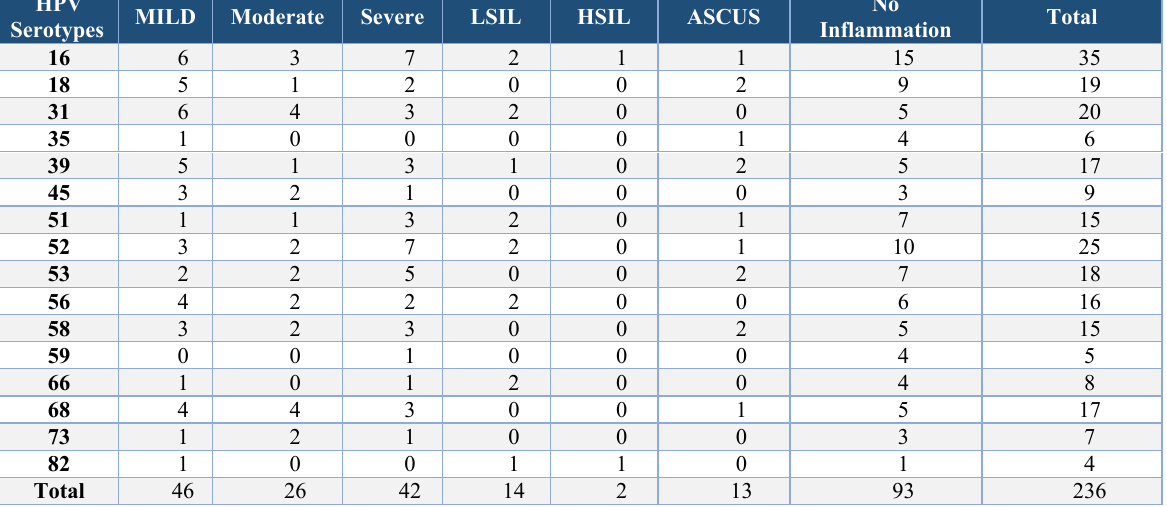
Table 1. Cytology * PAP Cross-tabulation